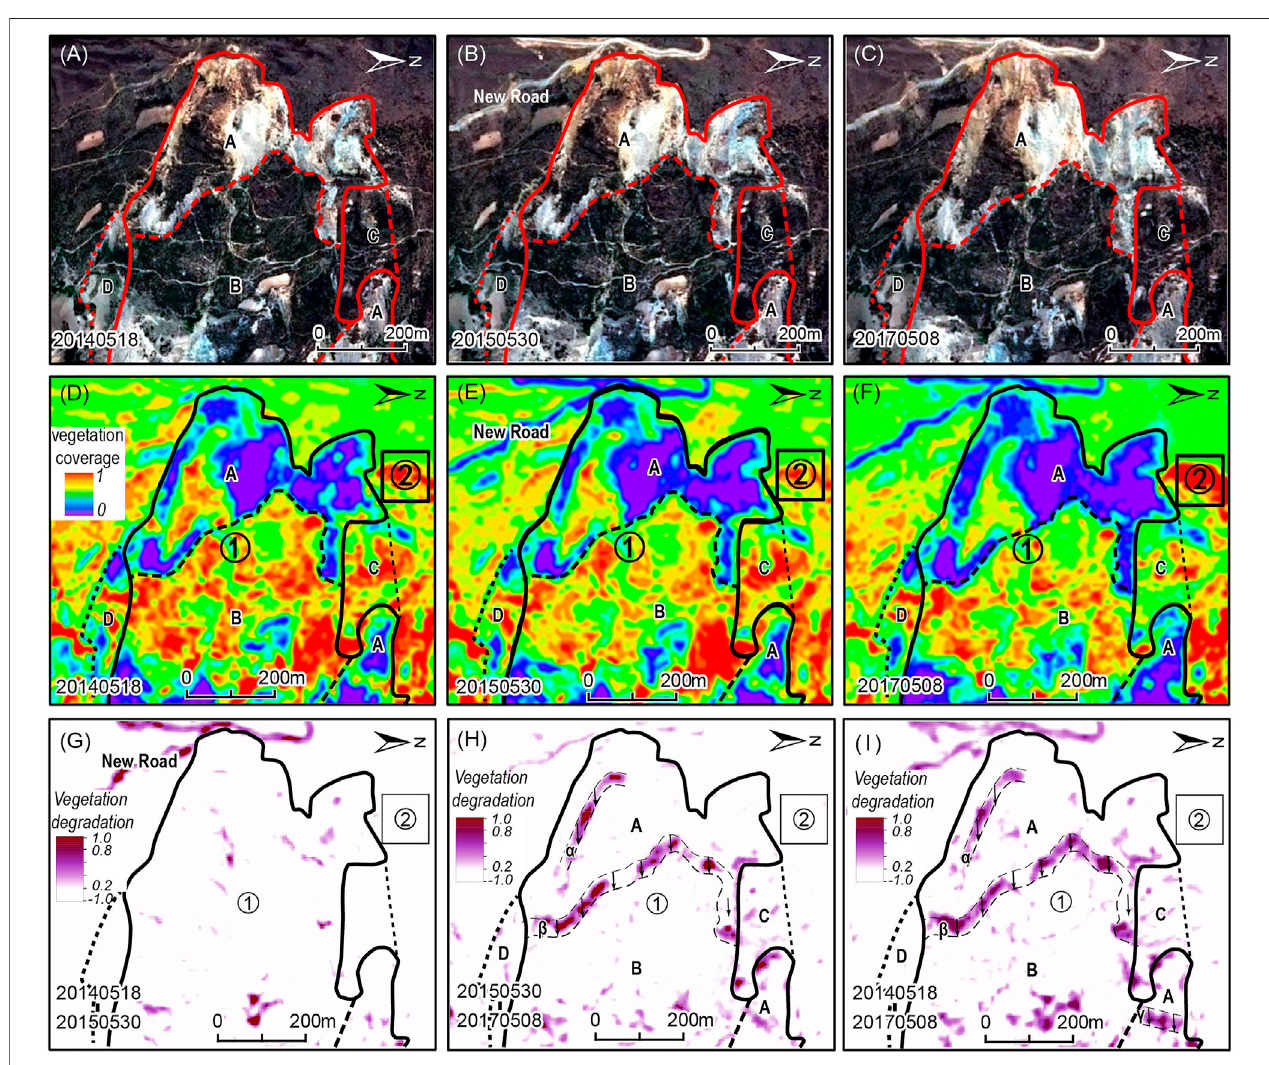
FIGURE 8 | Remote sensing data and vegetation coverage map of Baige landslide (A) SPOT-6 image of May 18, 2014 (B) SPOT-7 image of May 30, 2015 (C) SPOT-7 image of May 8, 2017 (D) Vegetation coverage map of May 18, 2014 (E) Vegetation coverage map of May 30, 2015 (F) Vegetation coverage map of May 8, 2017 (G) Vegetation coverage change map of 2014 – 2015 (H) Vegetation coverage change map of 2015 – 2017 (I) Vegetation coverage change map of 2014 – 2017.